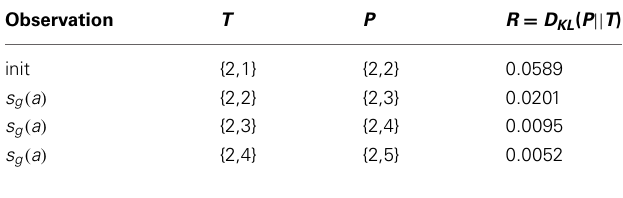
Table 2 | A predictable action ends in the predicted state.